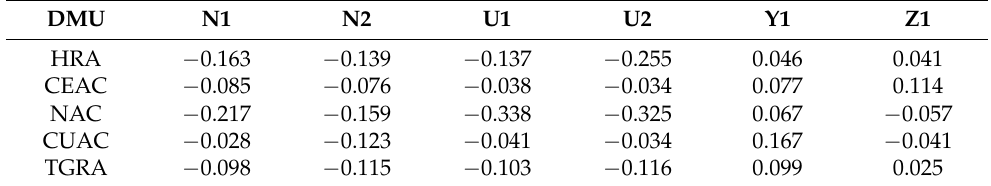
Table 5. Improvement in input–output indicators in the four major regions of the TGRA in 2020. DMU N1 N2 U1 CEAC − 0.085